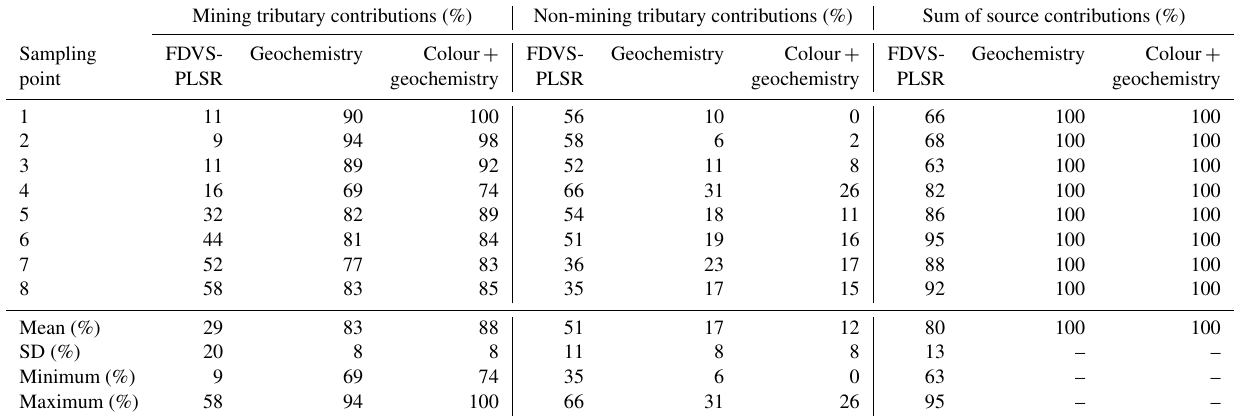
SD: standard deviation. Table 5. Source contributions calculated by FDVS-PLSR, geochemistry and colour + geochemistry approaches for sediment deposited during the flood of 10 April 2017. Mining tributary contributions